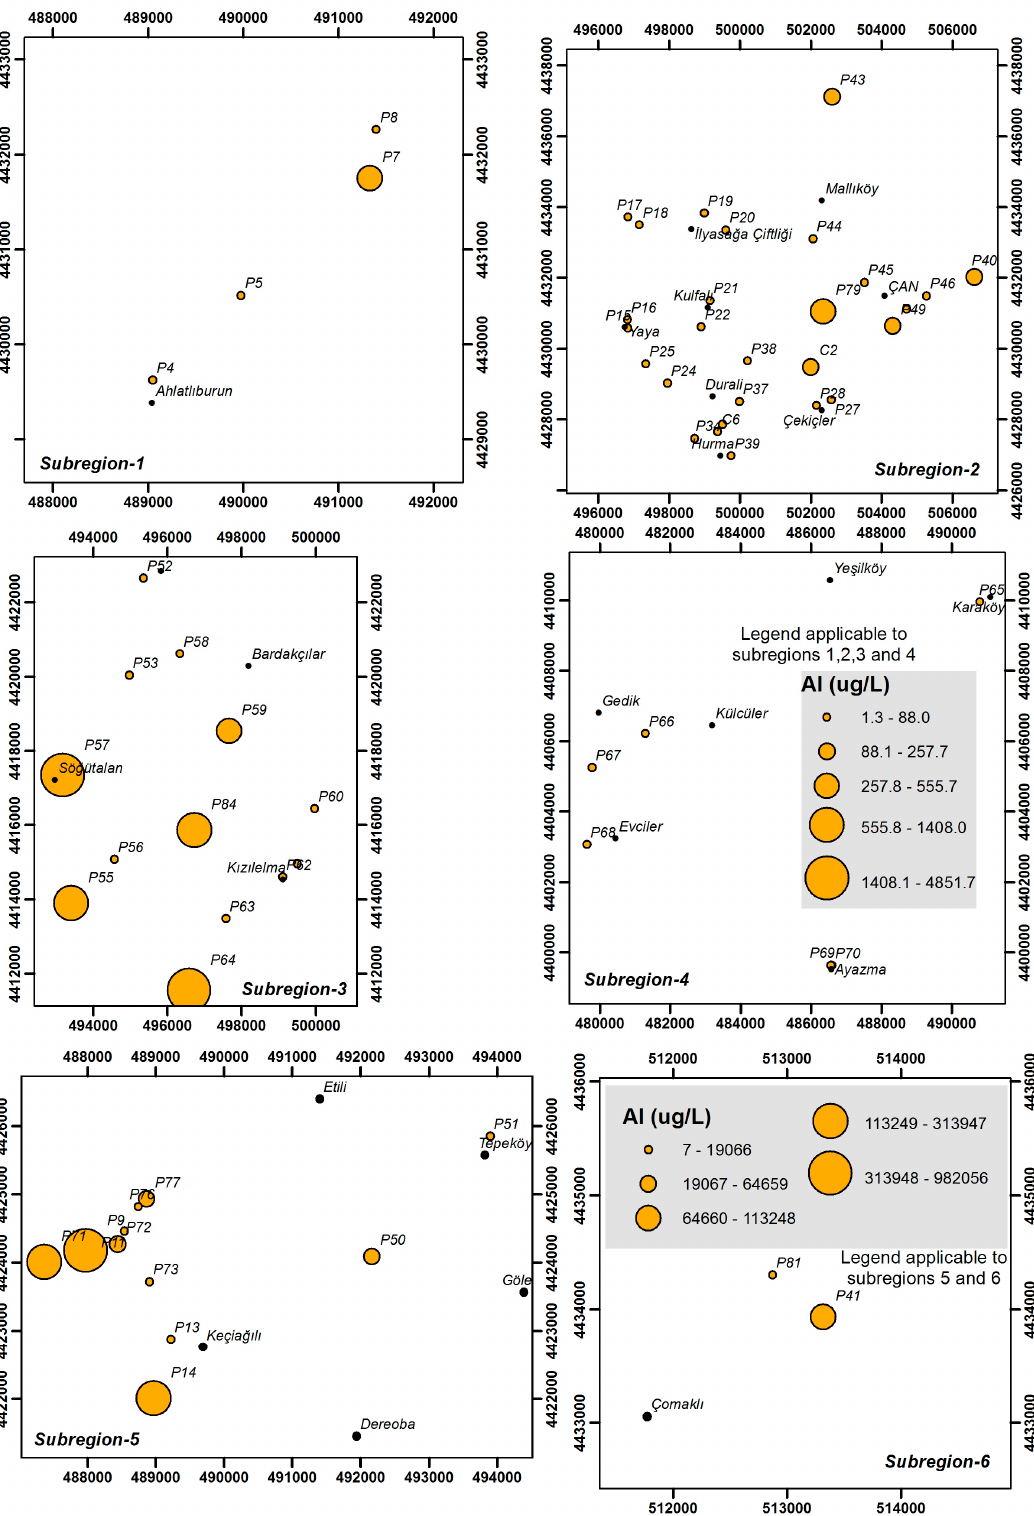
Figure 8. Spatial distribution of aluminum.